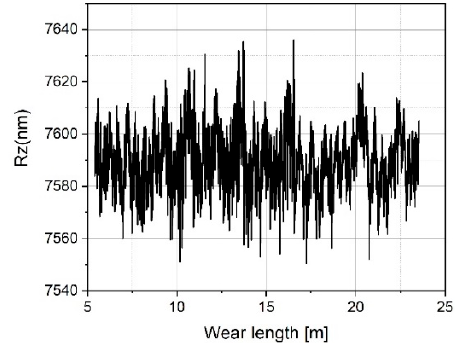
Figure 25. Measured Rz values on the roughness standard RN 6678 versus measurement length.